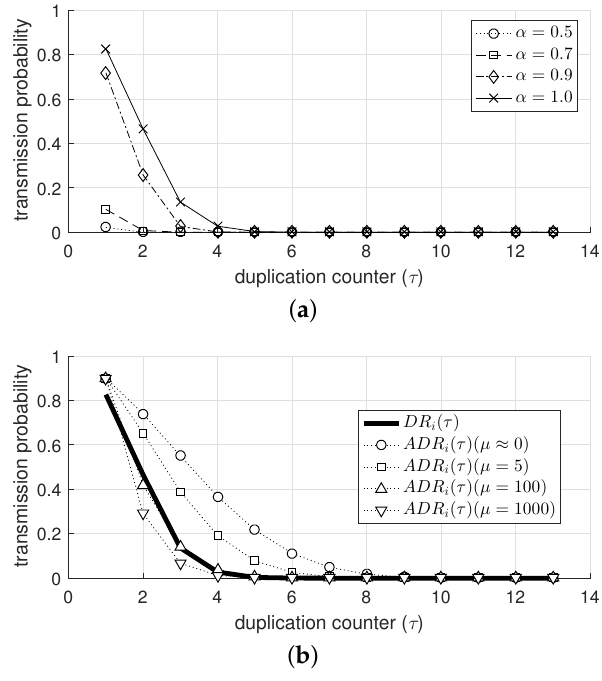
Figure 6. The transmission probability obtained from ( a ) duplication ratio with various values of α and ( b ) approximated duplication ratio with various values of µ